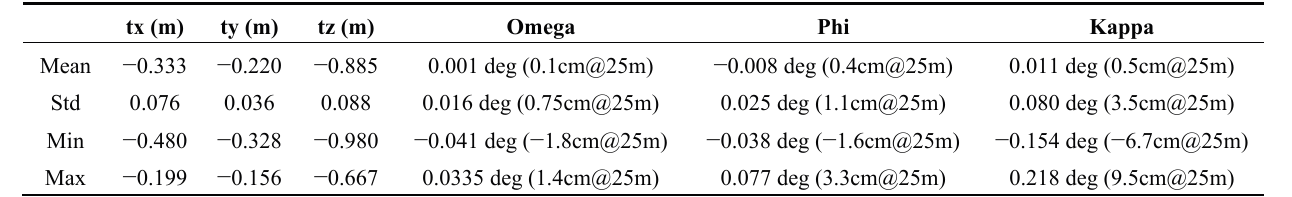
Table 4. The summary of transformation parameters for ALS/MLS registration.